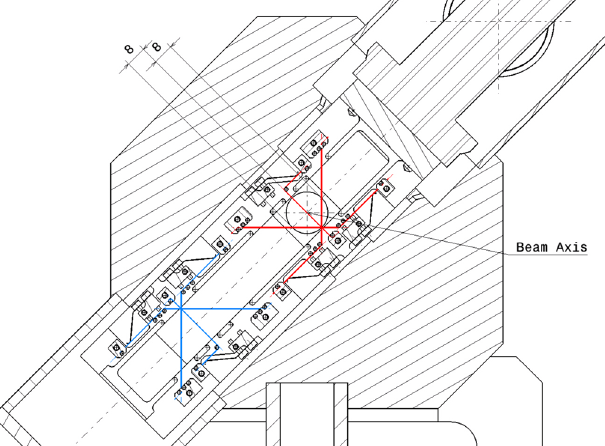
FIG. 45. Front-view of the wire scanner vacuum chamber and the wire-fork. The wire-fork is equipped with 3 different pin slots where 5 μ m tungsten wires can be stretched (indicated as red and blue lines). The distance between the “ wire vertex ” and the vacuum-chamber center can be set to 8, 5.5 and 3 mm corre- sponding to the 3 different pin slots.